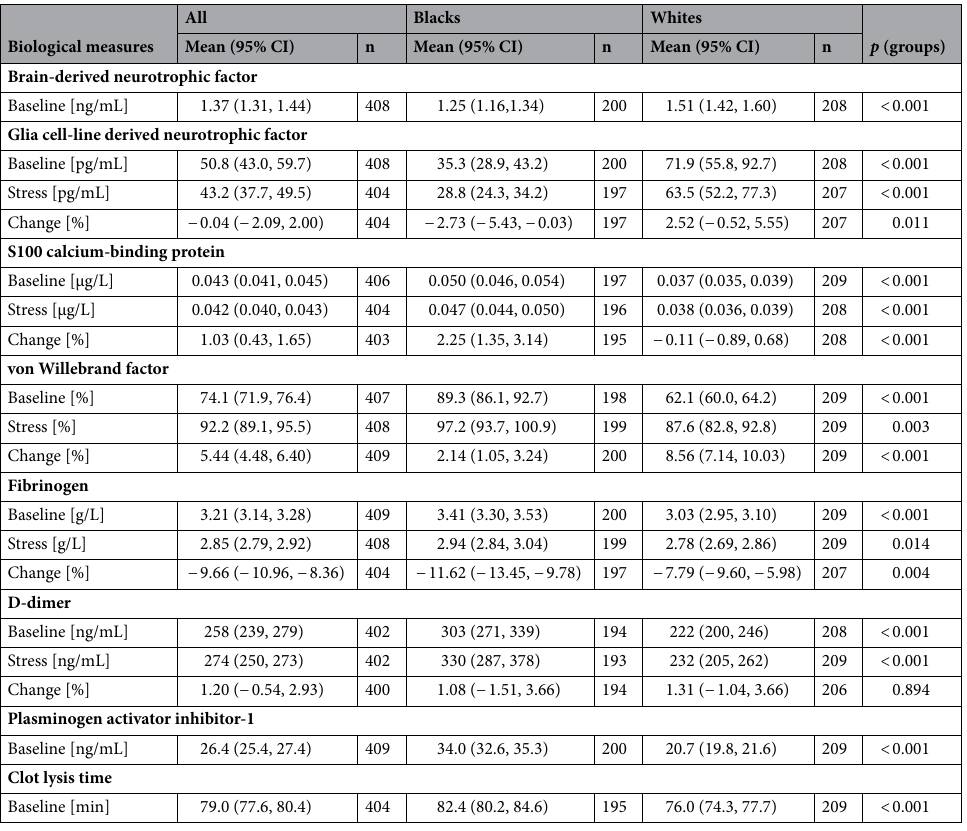
Table 3. Baseline values, values after stress and stress-induced percent changes in neurotrophins and hemostatic factors (without outliers). Values are geometric or percentage mean with 95% confidence interval (CI). See supplementary information for the number of outliers (i.e., 3 standard deviations above or below the sample mean). Two participants taking oral anticoagulants were additionally excluded for D-dimer